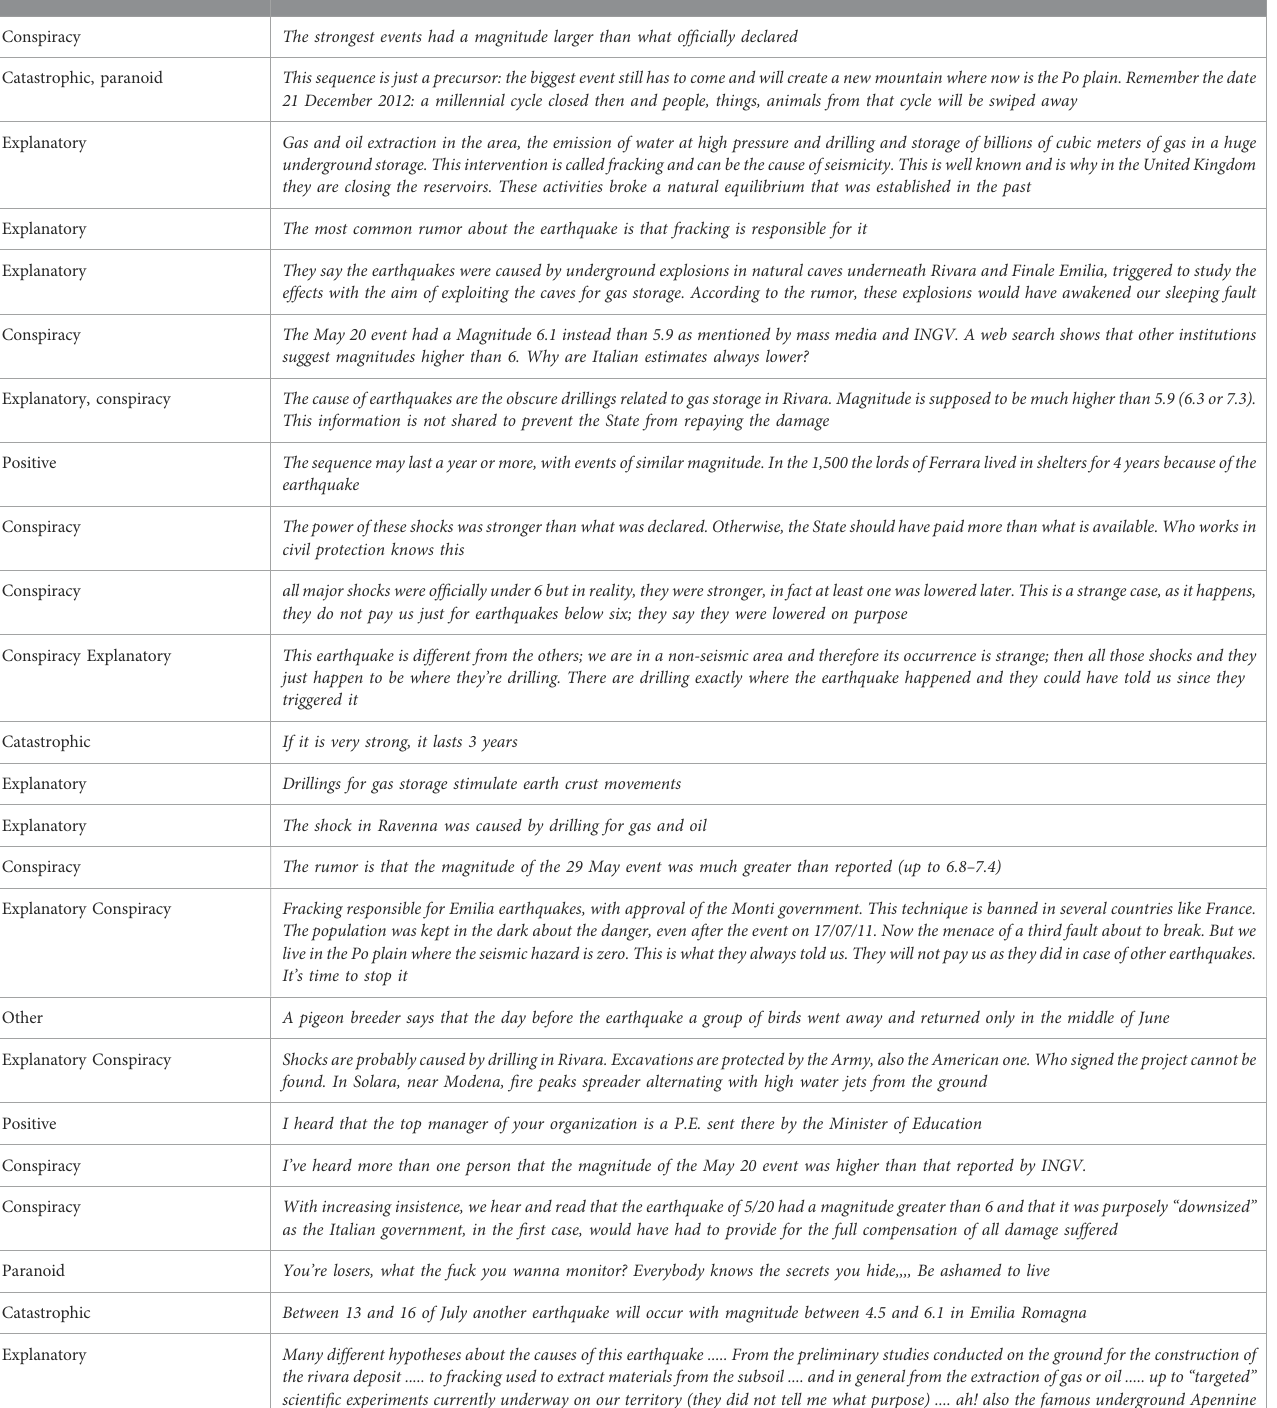
TABLE 5 List of the strongest rumors collected (R =